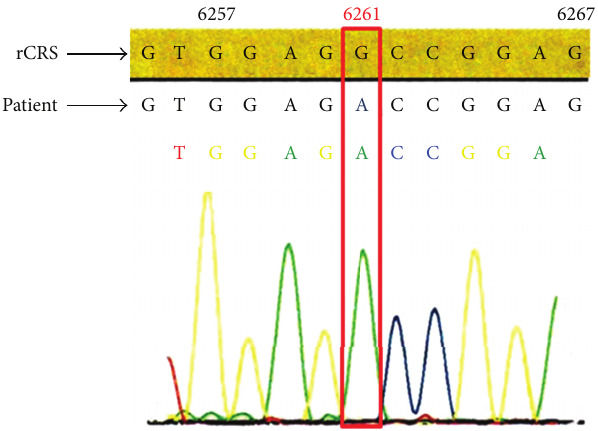
F 1: e mtDNA sequencing chromatogram shows the presence of the G A mutation at position 6261 in one patient compared to the revised Cambridge Reference Sequence →